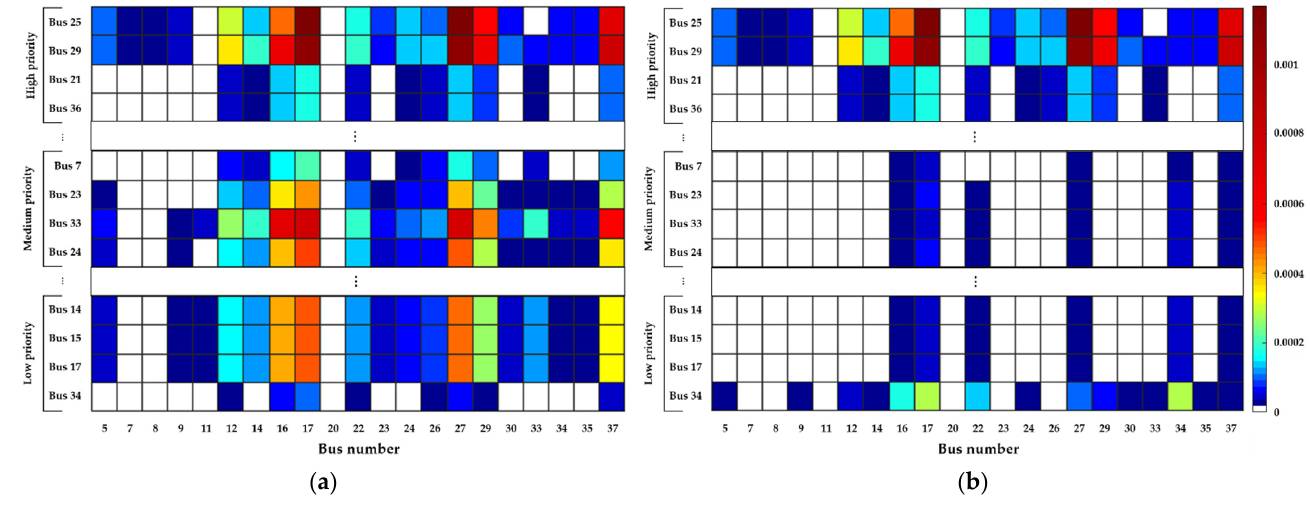
Figure 6. Voltage stability improvement heatmap for ( a ) the new ESS installation at bus 25 (optimal placement: high priority, recommended) and ( b ) the new ESS installation at bus 34 (comparison case: low priority, not recommended) according to the load changes. Table 4. Comparison of RMSE voltage according to ESS installation and installation placement. Without